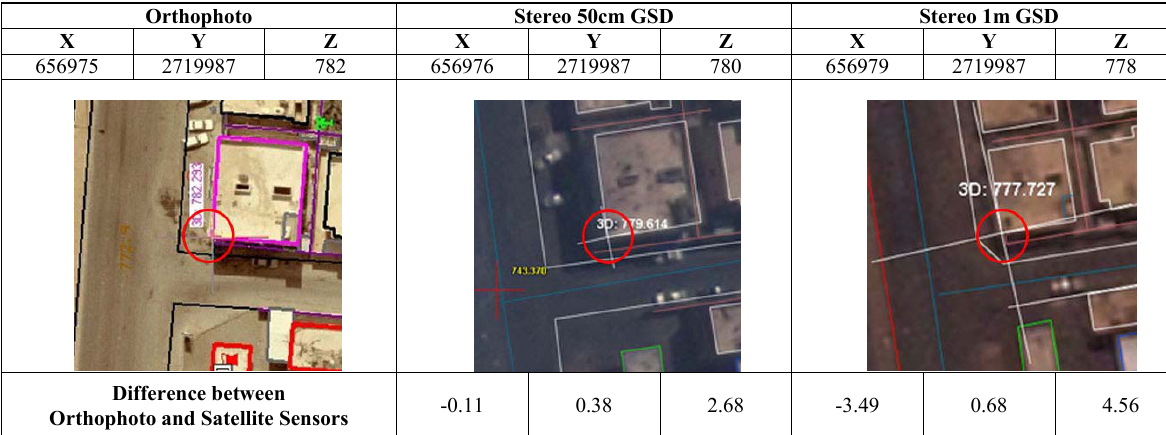
Table 1c. showing comparability between Orthophoto and Satellite imagery adjacent to